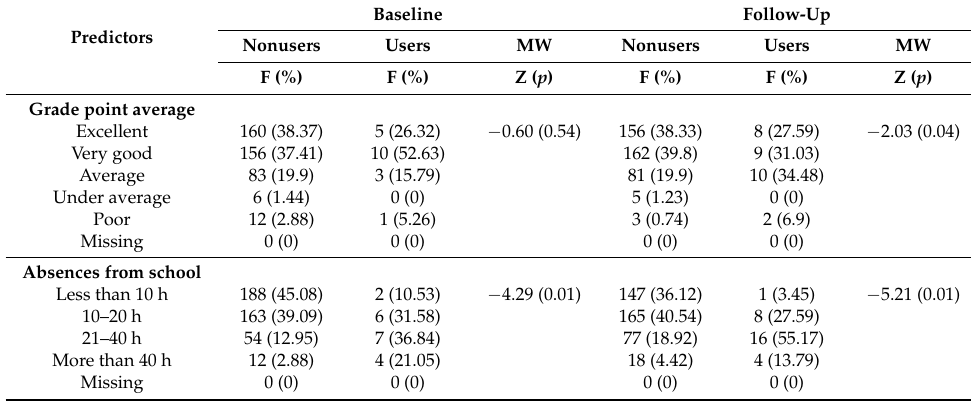
Table 1. Baseline and follow-up results for scholastic variables (F—frequency, %—percentage) with differences on a basis of consumption of illicit drugs (MW—Mann Whitney Z values, p —level of